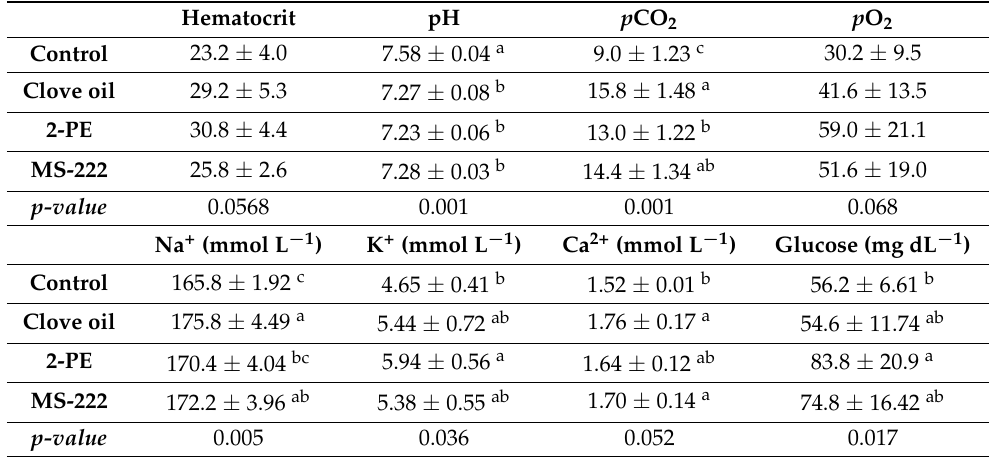
Table 2. The effect of clove oil (5 mL L − 1 ), 2-phenoxyethanol (2-PE; 0.4 mL L − 1 ) and MS-222 (120 mg L − 1 ) on blood pH, hematocrit electrolyte levels, glucose and pCO 2 and pO 2 in juvenile cobia. Different superscripts in individual columns signify significant difference at the α < 0.05 level by Duncan’s multiple range